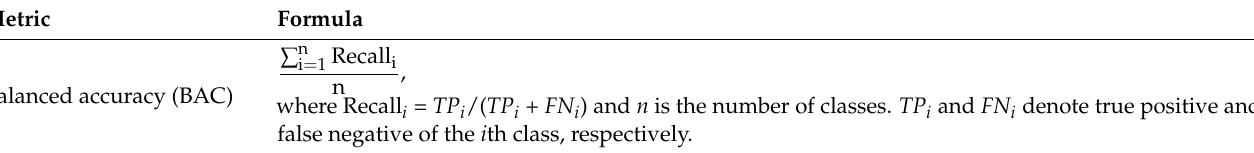
Table 4. Performance metric